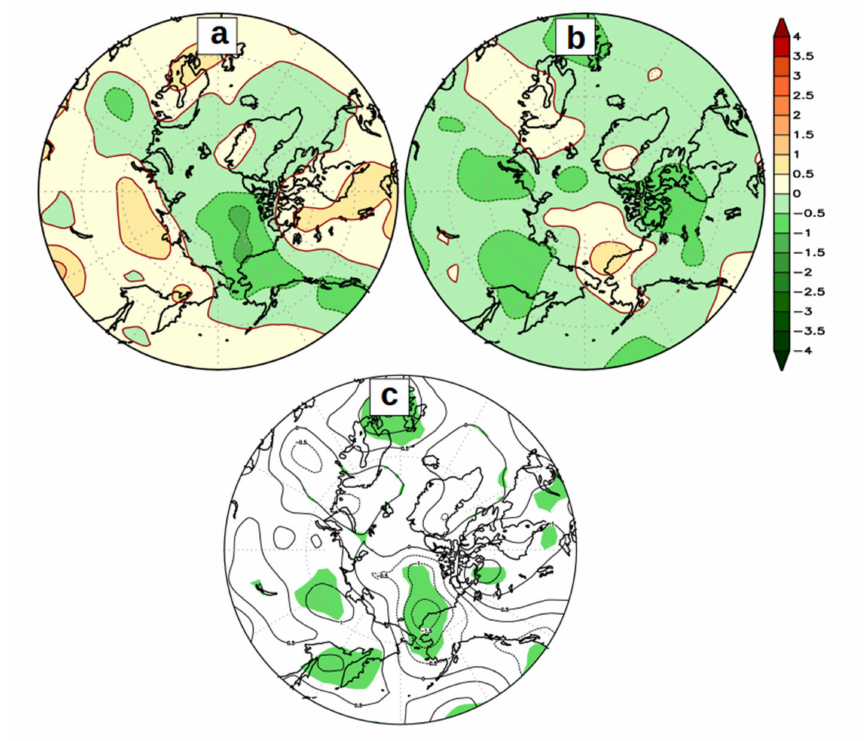
Figure 8. Composites of JJAS temperature anomalies ( ◦ C) at lower troposphere (925 hPa) ( a ) strong ISM years, and ( b ) weak ISM years, and ( c ) the difference between ( a , b ) with statistically significant regions shaded at a 95% significance